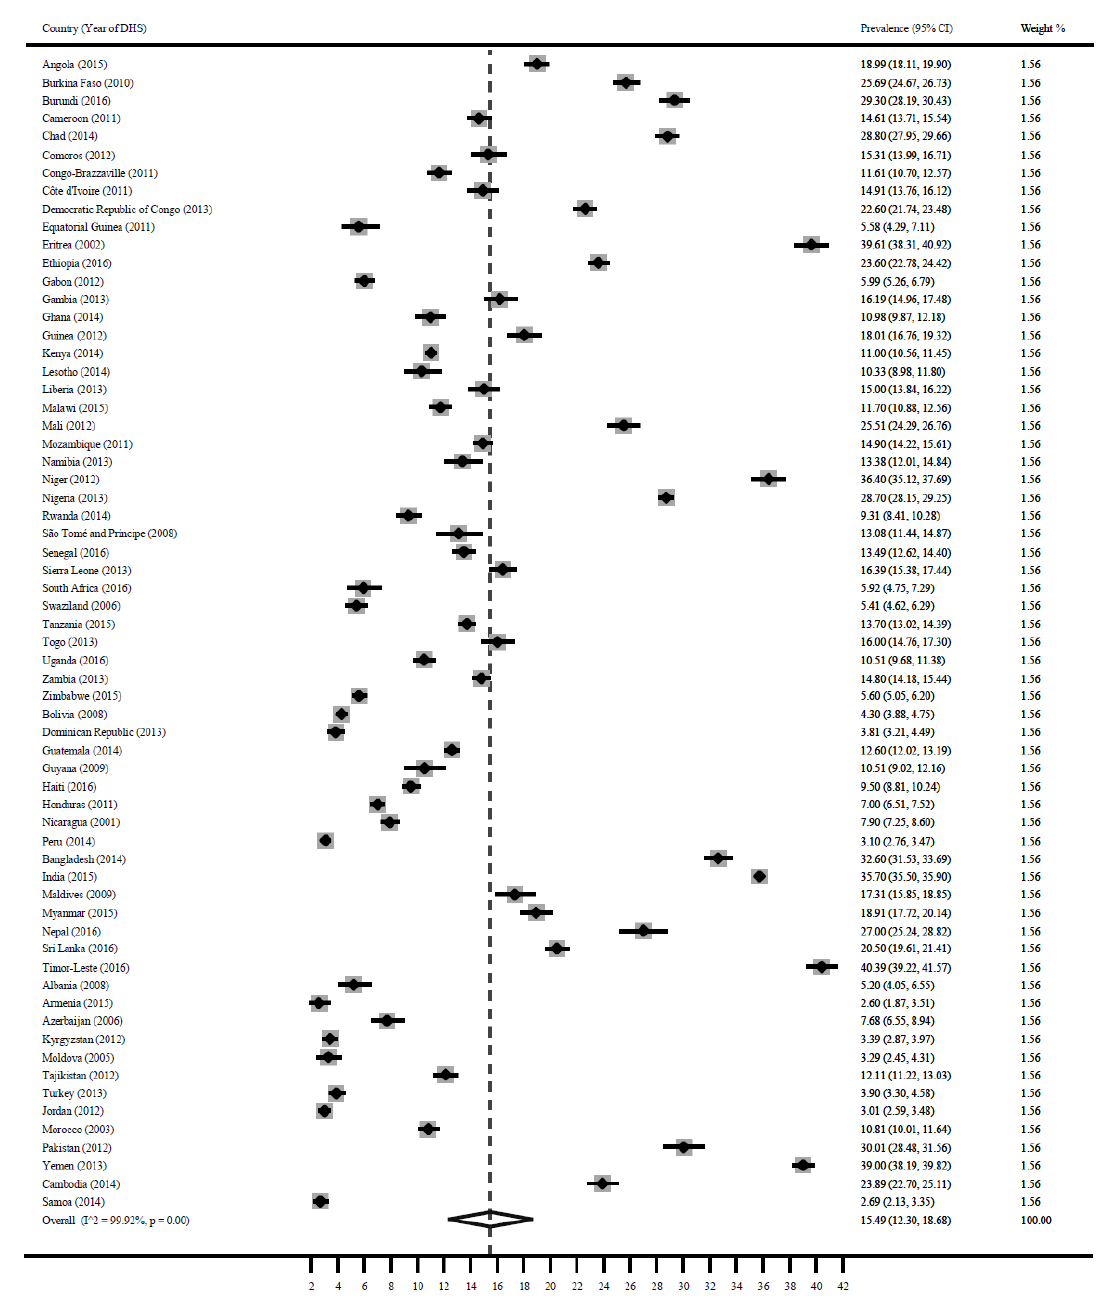
Figure 3. Prevalence of child underweight in LMICs.